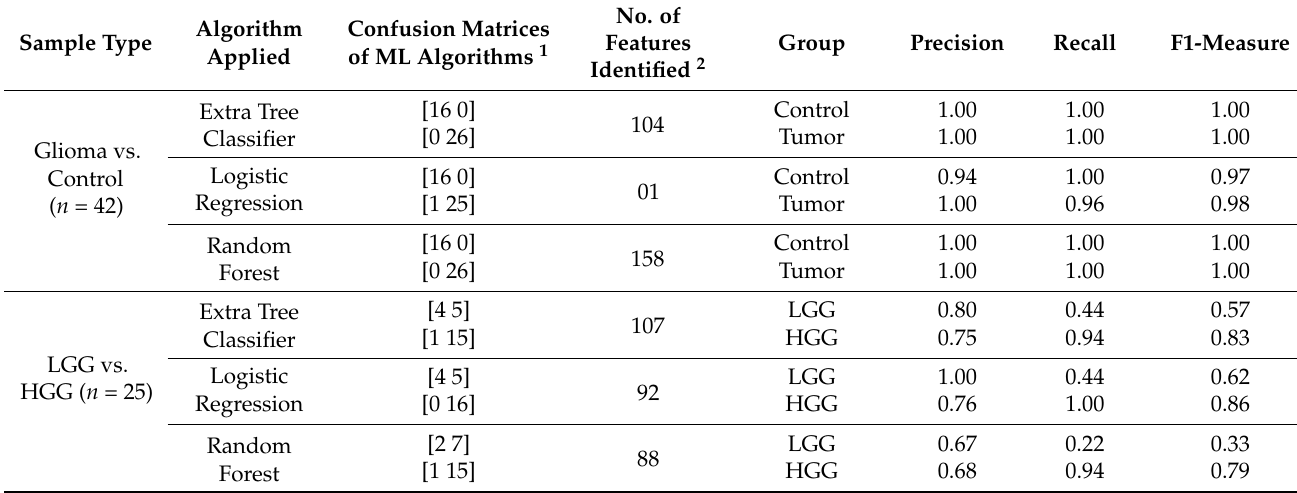
Table 2. Performance and confusion matrices of machine learning (ML) algorithms applied for the detection and classifica- tion of glioma in the study subjects.